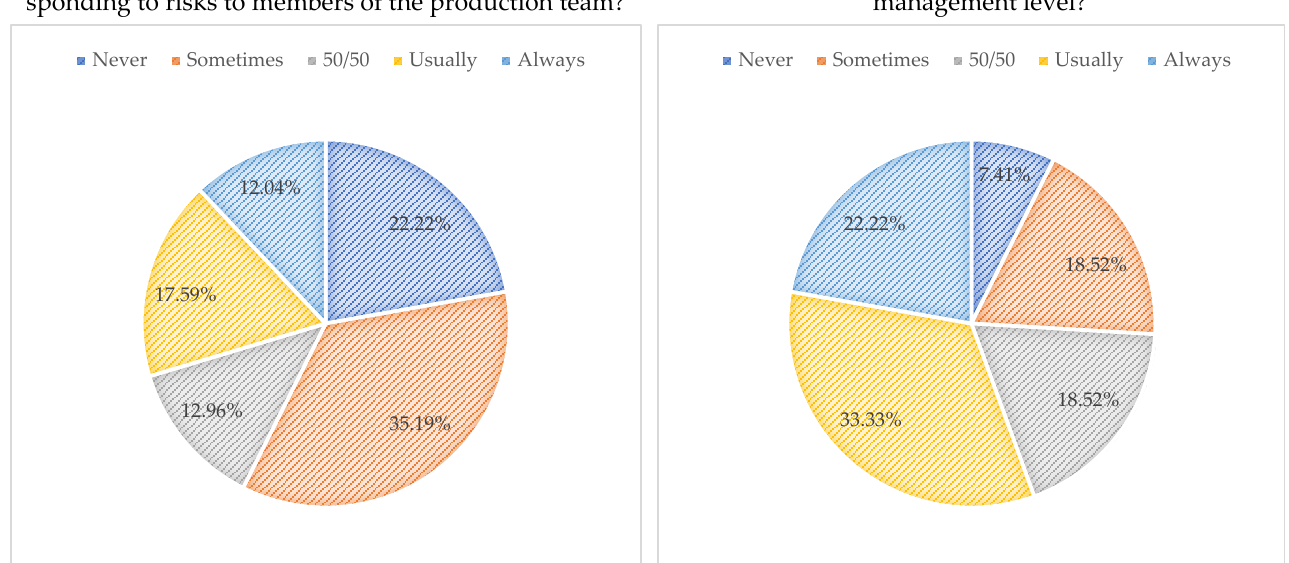
Figure 4. Delegation of responsibility and escalation of key risk factor management (n = 108).